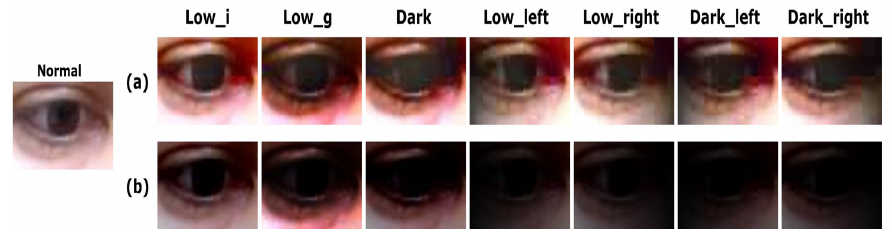
Figure 10. Comparison of images of the eye: ( a ) Images enhanced by EnlightenGAN. ( b ) Original low and dark illuminated images.